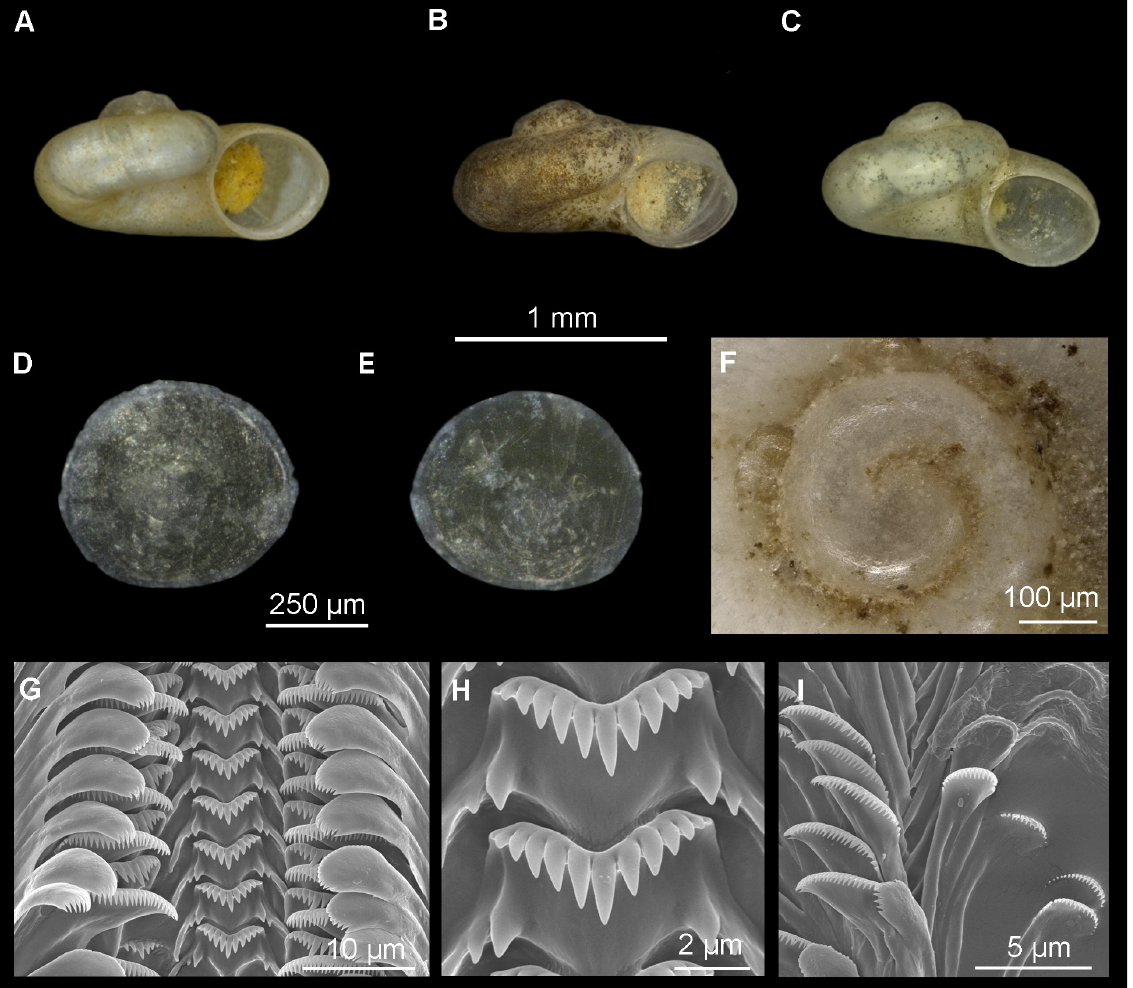
Fig. 2. Shells, operculum and radulae of Docleiana tabanensis (Boeters, Glöer & Pešić, 2014) (UGSB 18847). A–C . Shells. D–E . Operculum (D = inner side; E = outer side). F . Protoconch. G–I . Radulae. G . Portion of radula ribbon. H . Central radular teeth. I . Inner and outer marginal